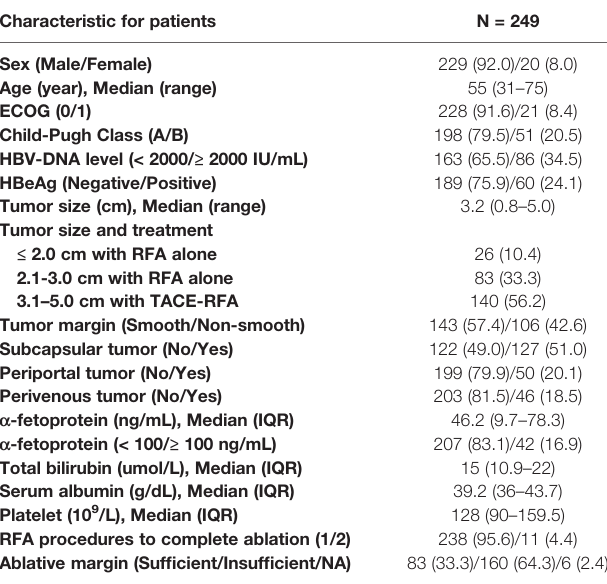
TABLE 1 | Baseline characteristics of the 249